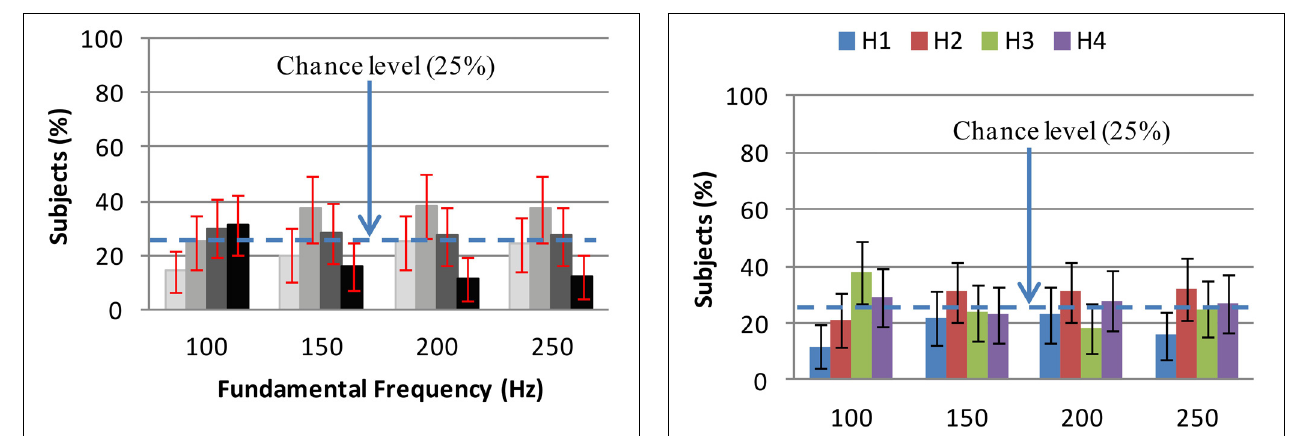
FIGURE 6 | Grayscale selections for fundamental frequency: each grayscale bar shows the selection rate of the same grayscale. The error bars show the 98.3% confidence intervals for the selection rates. The grayscales are, from the lightest to the darkest, 0.9, 0.6, 0.3, and 0 (black). When considered alone, the grayscales are not associated with fundamental frequency. But when dark scales (0 and 0.3) are compared with lighter scales (0.6 and 0.9), dark scales selections have decreased while lighter scales selections have increased with fundamental frequency (See details in the text).